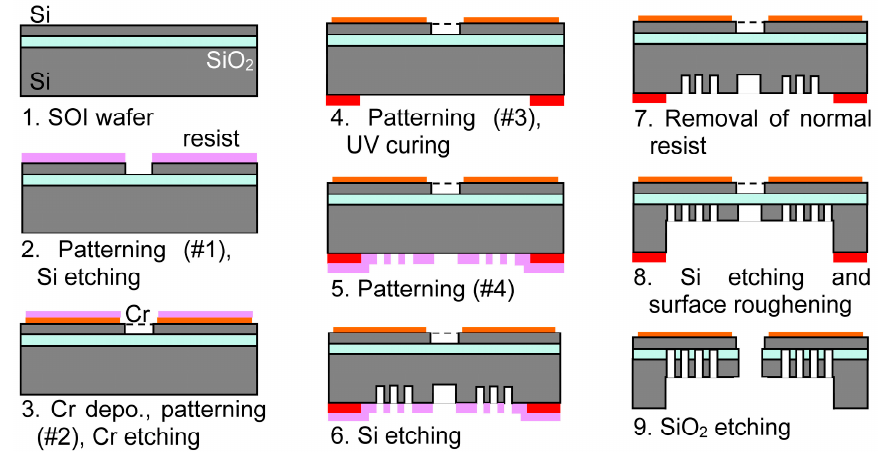
Figure 4. Fabrication sequence of the microheater with the thin membrane.